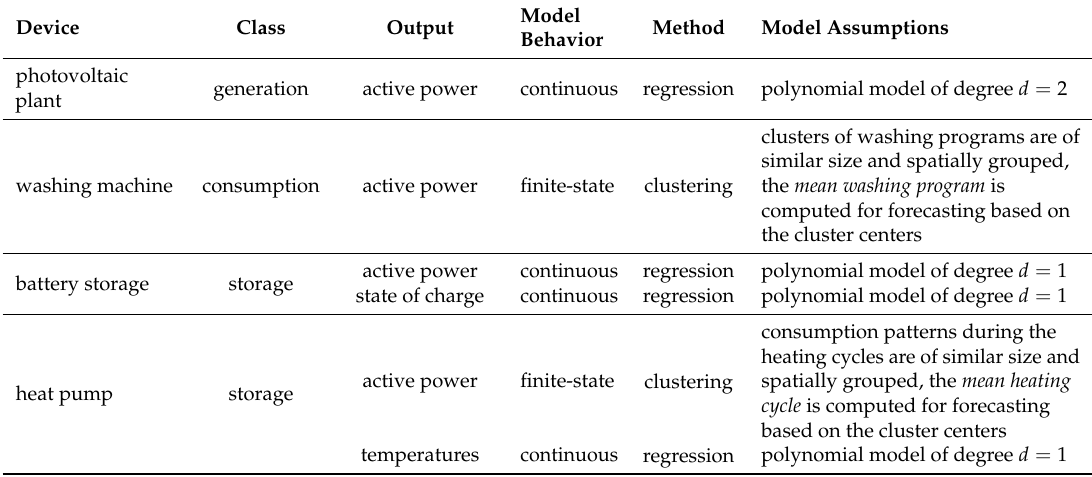
Table 2. Chosen devices with classification and method for model